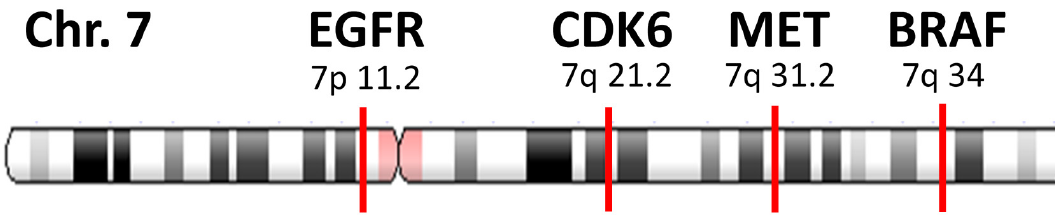
Figure 1. Gene location on chromosome 7. In chromosome 7, the EGFR gene is located in 7p 11.2, whereas the other three genes ( CDK6 , MET , and BRAF ) are located in arm 7q.